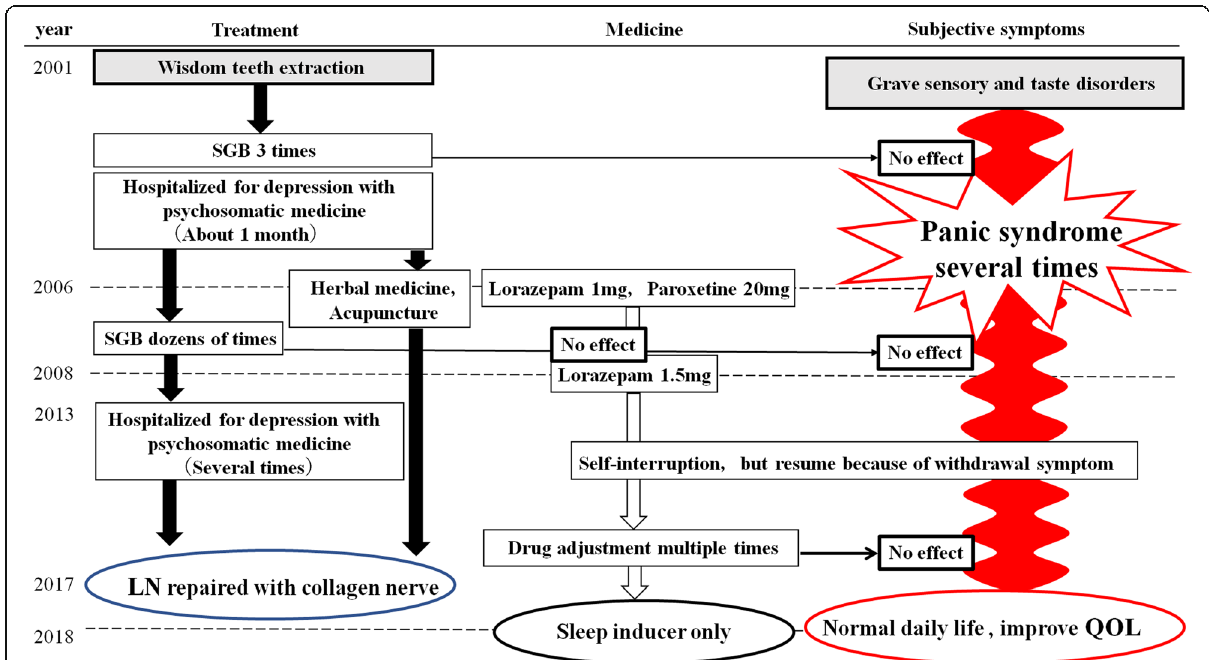
Fig. 4 Prognosis. The patient obliged to take heavy psychotropic drugs for a long time before LN reconstruction. After the operation, he could be free from the heavy psychotropic drugs. Quality of her life was drastically refined after this